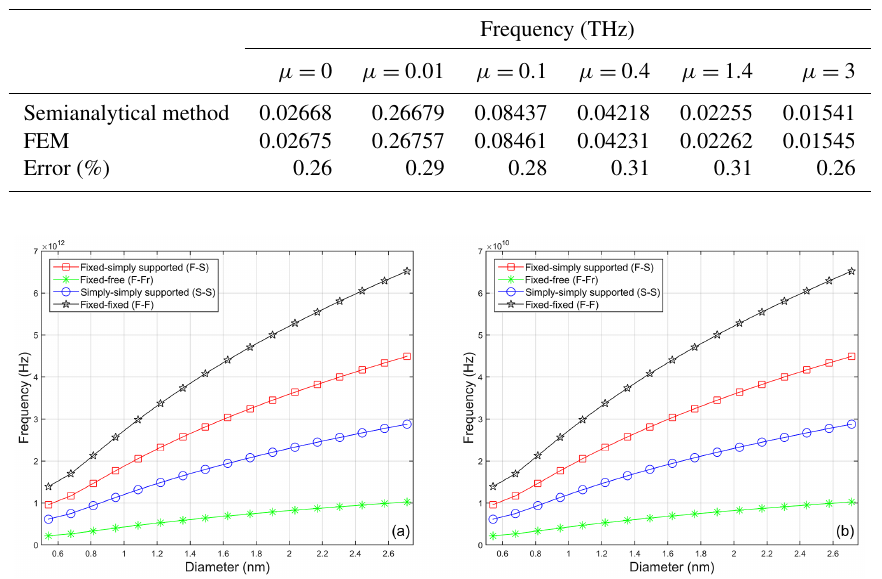
Figure 3. The first eigenfrequencies of armchair nanotubes with the nonlocal parameter µ = 0 . 01 and length (a) L = 10nm, (b) L = 100nm.